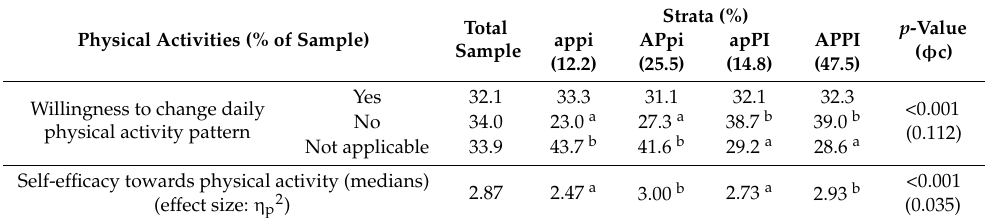
Table 6. Strata profiles based on attitude towards physical activity in 1825 adults aged 65 years and older from five European